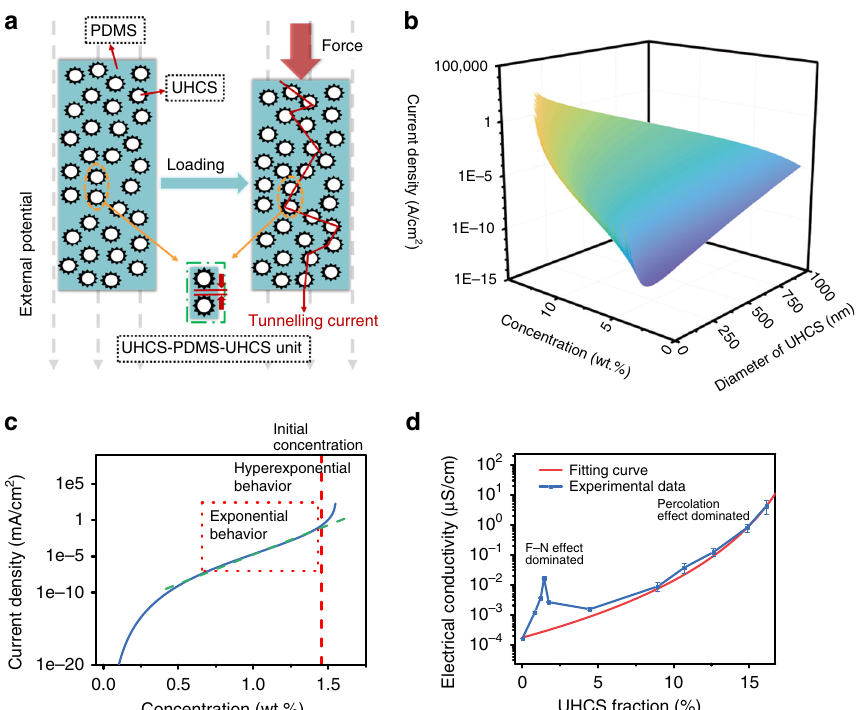
Fig. 4 Theoretical calculation of the relationship curves of the thin- fi lm sensor. a Sketch of urchin-like hollow carbon sphere, polydimethylsiloxane, urchin-like hollow carbon sphere (UHCS-PDMS-UHCS) units when pressure is exerted. b Three-dimensional diagram of the current density versus the concentration and diameter of the urchin-like hollow carbon sphere (UHCS). c Relationship between the current density and the fraction of UHCS. d Results of the electrical conductivity test with different concentrations of urchin-like hollow carbon sphere polydimethylsiloxane fi lm (UHCS-PDMS) and a fi tting curve of the percolation effect. The error bars represent one standard